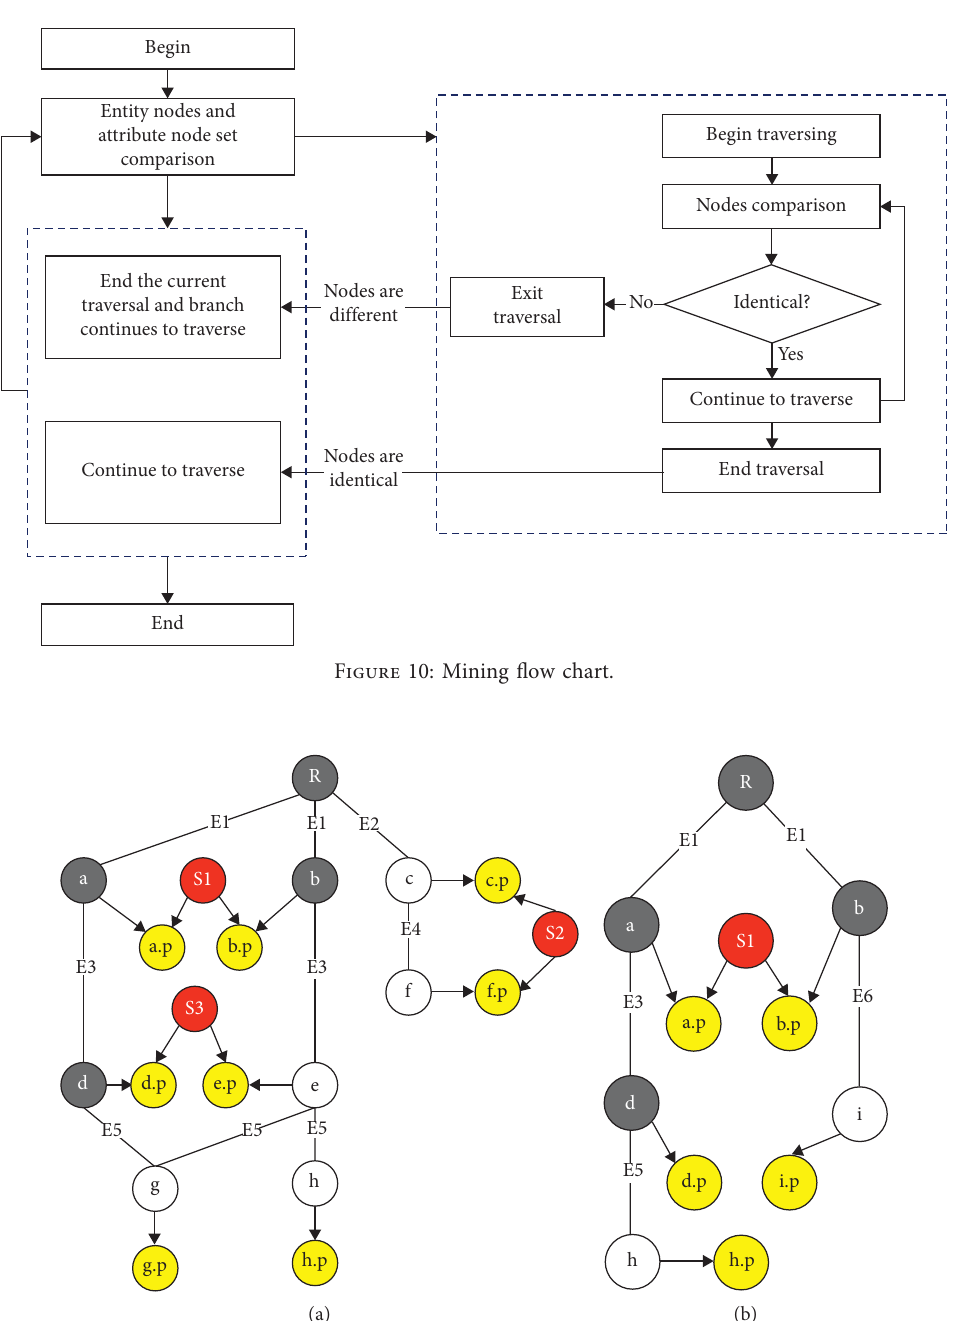
Figure 11: Two IFC graphs to be merged: (a) merging file graph and (b) merged file